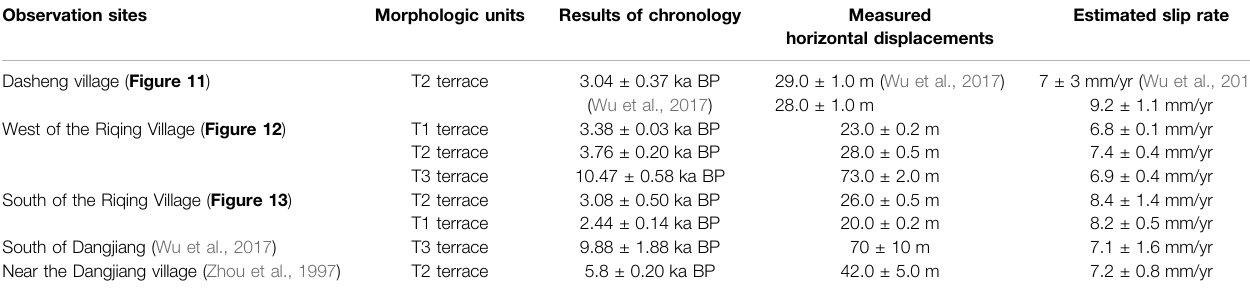
TABLE 3 | Estimated Holocene slip rates of the typical observation sites along the DFZ.